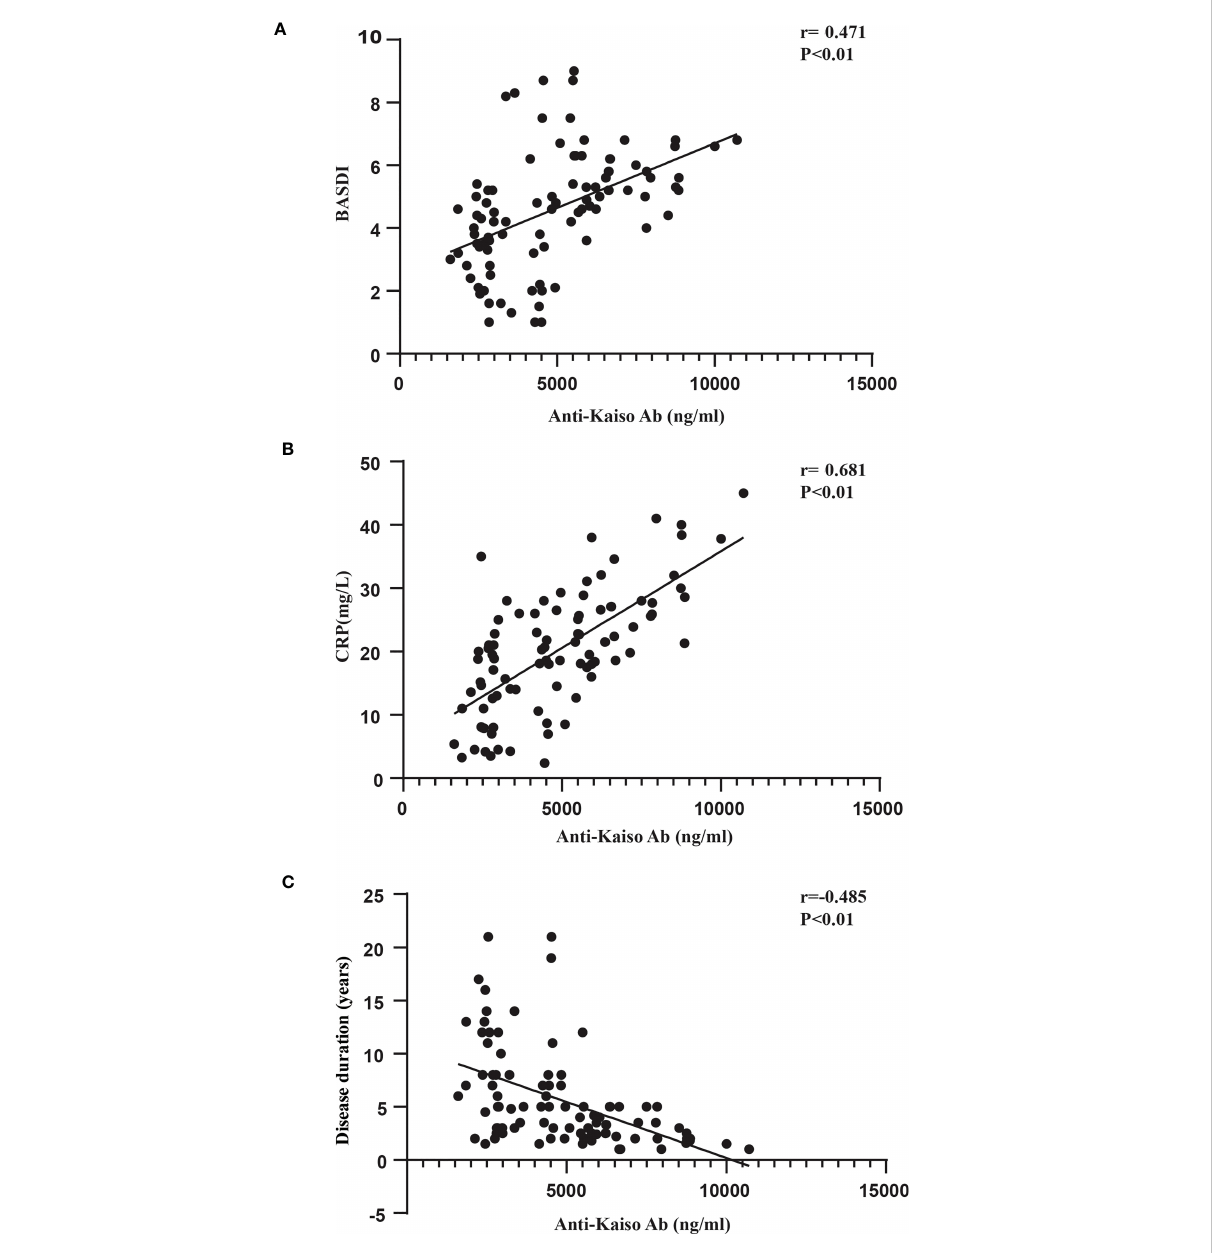
FIGURE 4 Correlation between anti-Kaiso autoantibody levels, BASDAI scores (A) , CRP (B) , and disease duration (C) in patients with